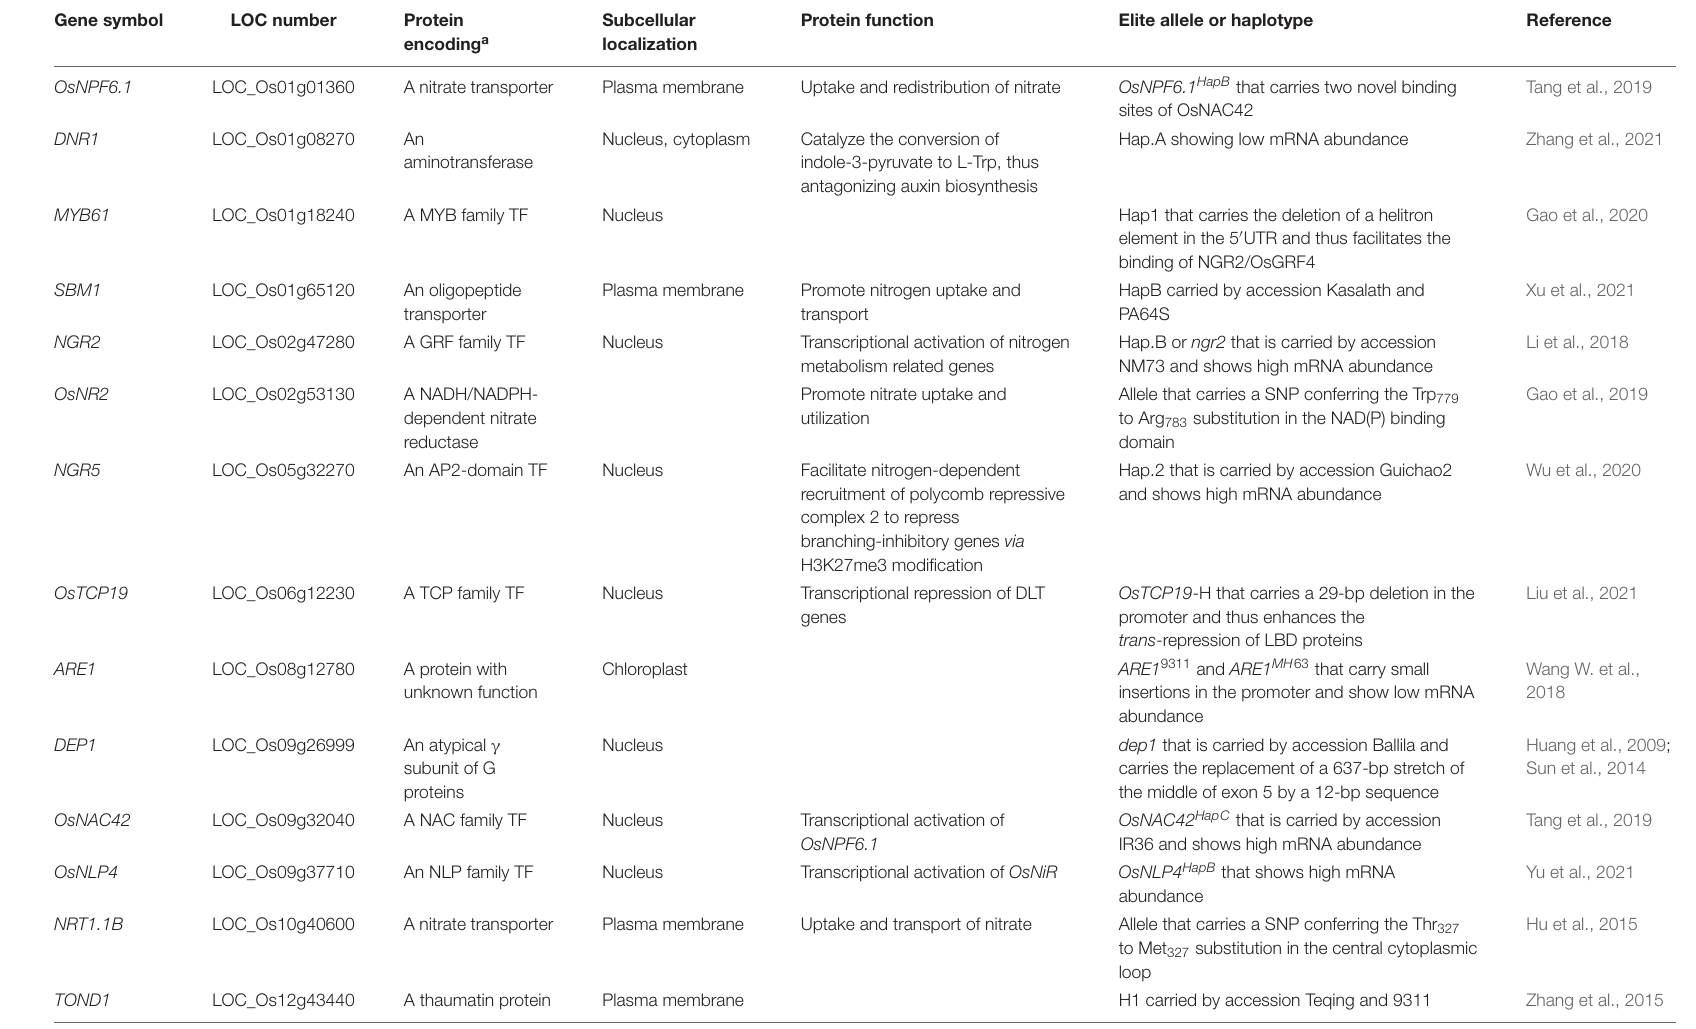
TABLE 1 | Information of 14 cloned NUE